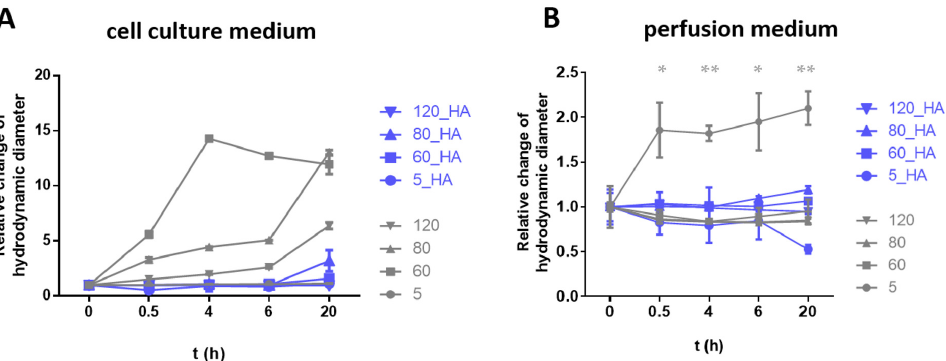
Figure 2. Colloidal stability of NPs in cell culture and perfusion media. The stability of AuNPs (grey lines) and HA-AuNPs (blue lines) was tested in cell culture medium ( A ) and in perfusion medium ( B ) over a time period of 20 h. The hydrodynamic diameter after certain time points was related to the initial hydrodynamic diameter (t = 0 h) and reported as the relative hydrodynamic diameter. Measurements were taken after 0, 0.5, 4, 6 and 20 h. AuNPs showed a significant increase in size after incubation in the cell culture medium. HA-AuNPs did not show an increase in size, indicating a higher stability in the cell culture medium. In perfusion medium, none of the particles showed a significant increase in size, indicating a sufficient stability. An exception was the 5 nm AuNPs. Statistically significant differences between 5 nm AuNPs and 5 nm HA-AuNPs are denoted by * or ** ( p < 0.05 or p < 0.01, respectively).